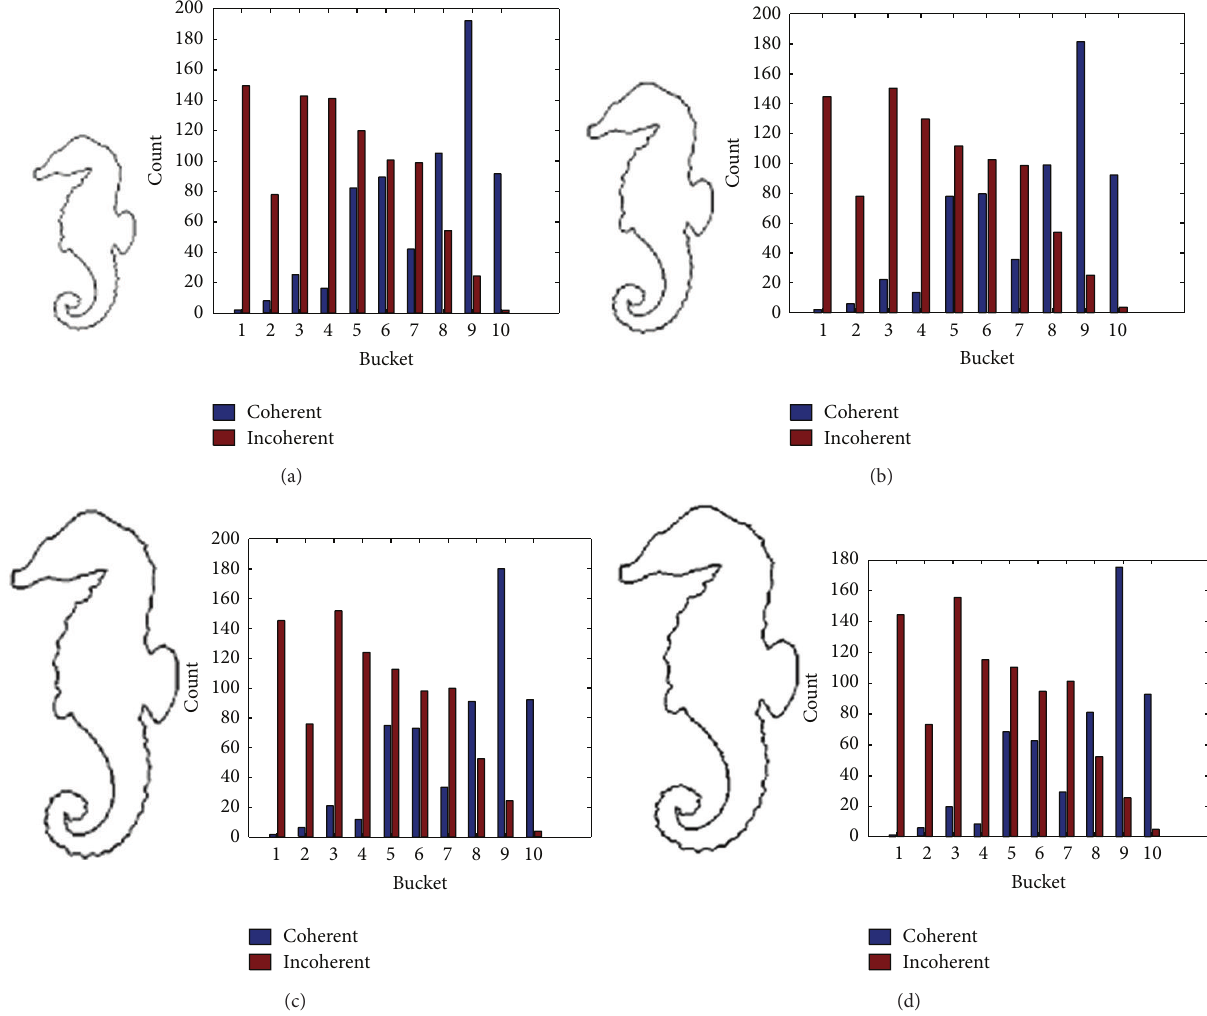
Figure 9: The MDCV histogram of Hippocampus images after scaling transformation. (a) Image scaled down 0.5 times; (b) image scaled down 0.8 times; (c) image scaled up 1.2 times; (d) image scaled up 1.5 times.